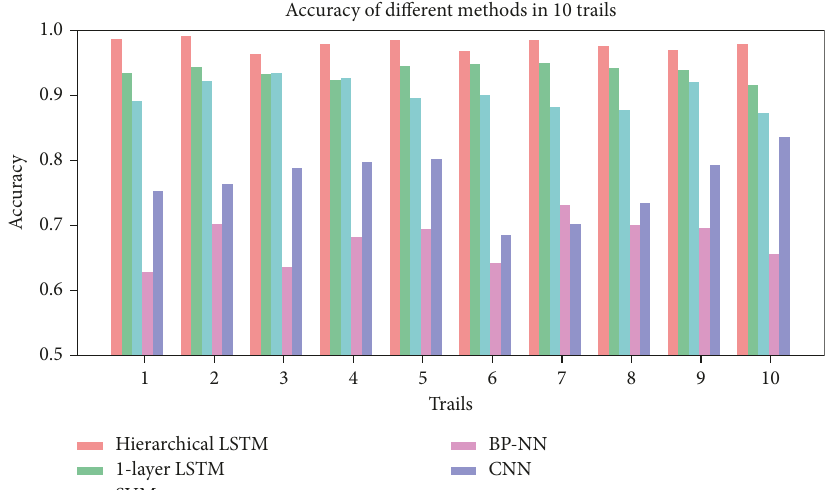
Figure 7: Experimental results of 10 trails.